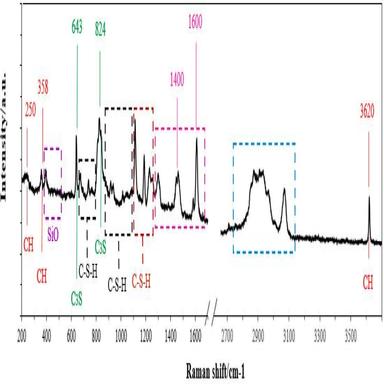
Typical Raman spectrum with several phases located in the crack samples with: (a) 0% CA, (b) 1% CA, and (c) 2% CA.